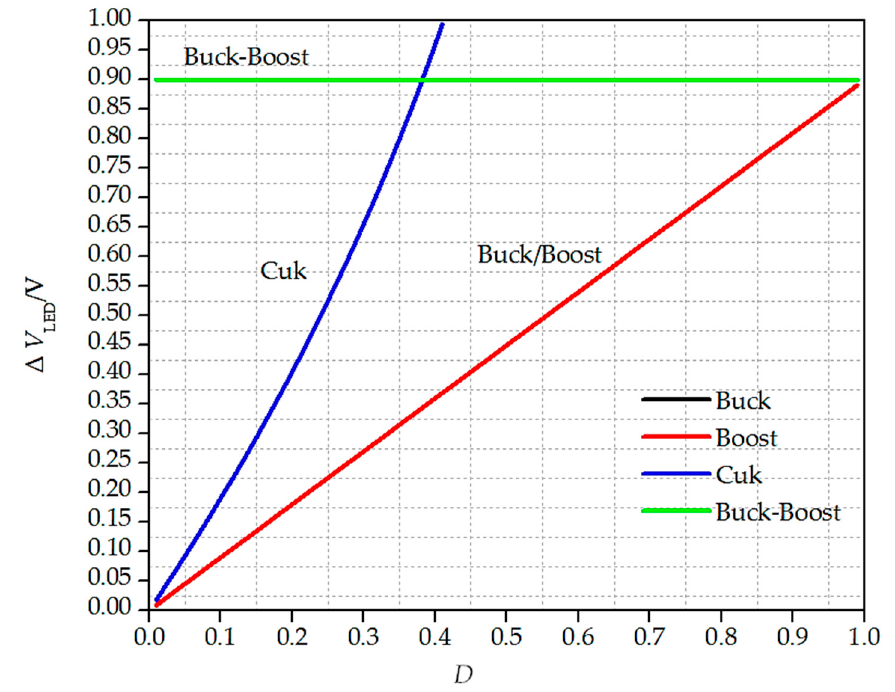
Figure 16. Relationship between voltage ripple magnitude and D of the LED in inductor converters.